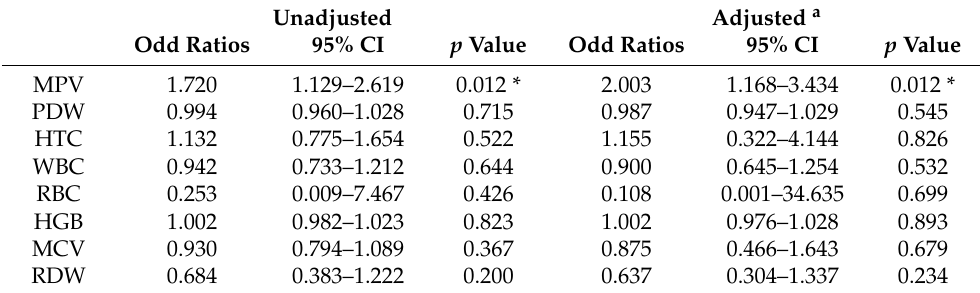
Table 4. Logistic regression analysis for BDI determined depression.